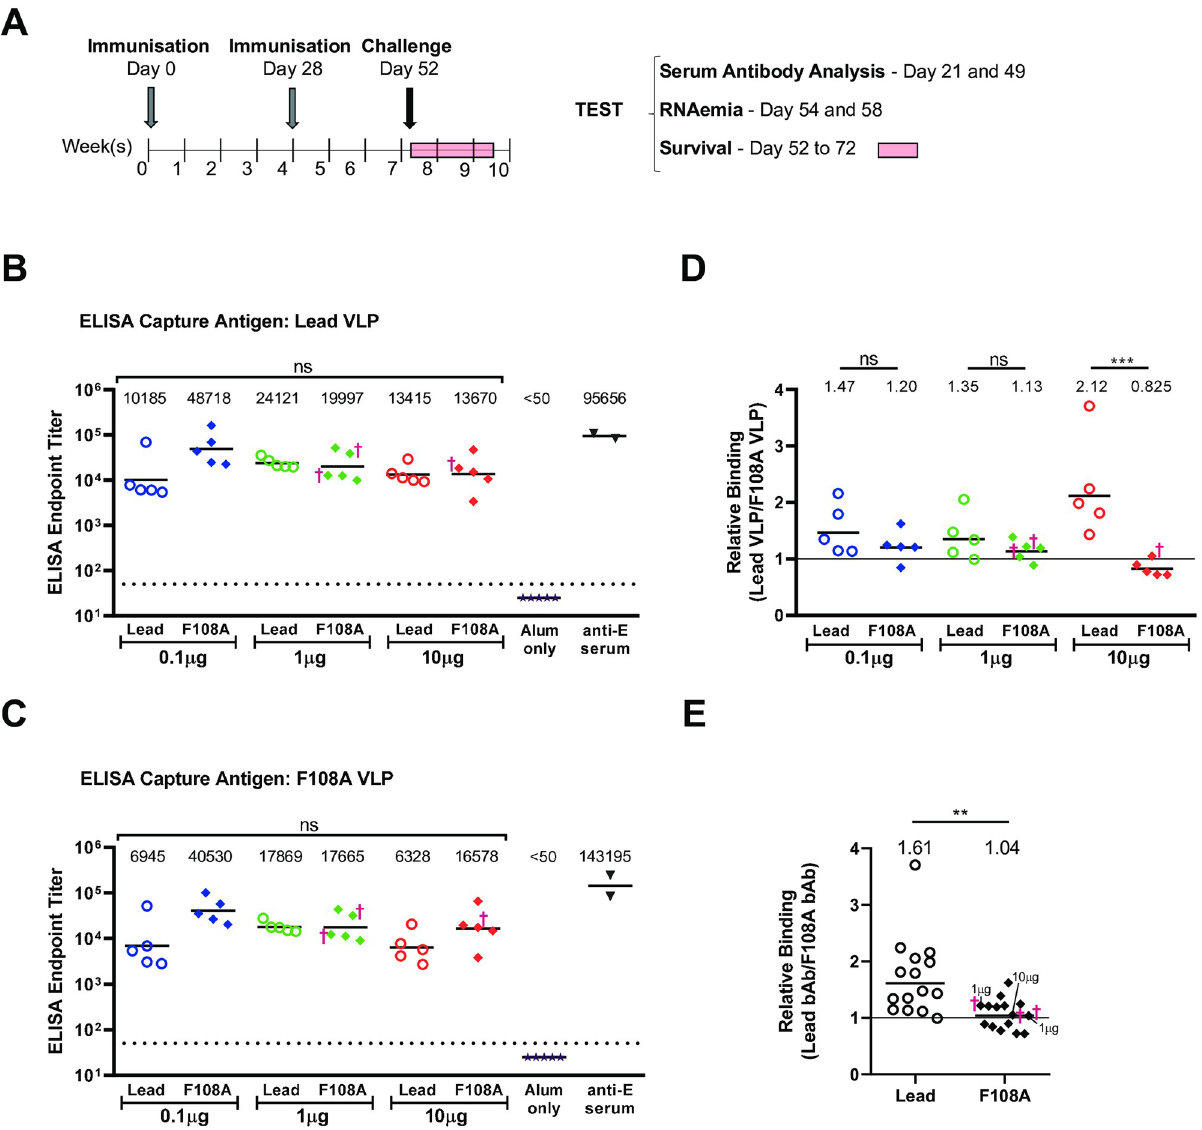
Fig 3. Vaccination and induction of lead and F108A VLP binding Abs. (A) Vaccination and bleeding schedule of AG129 mice are shown. Mice (5 per group) were immunized IM on day 0 and day 28 with doses of 0.1, 1, or 10 μ g VLP and alum adjuvant. Mice were subsequently SC challenged with ZIKV (Nica 2–16 strain) on day 52. Bleeding was performed on Days 21 and 49 of the study prior to viral challenge. Day 49 sera were tested by sandwich ELISA using captured lead (B) or F108A (C) VLPs, and endpoint titers were calculated. Each symbol represents the mean endpoint dilution of two independent measurements for an individual animal, and the geometric mean titer is depicted by a horizontal bar. The dotted line is the limit of detection (LOD) of the assay, and sera with undetectable binding were assigned a value of one-half LOD (25). Anti-E ZIKV mouse serum (Zoonogen, cat#pa10049) was used as a positive control and to demonstrate binding availability of E for the VLP types. For each capture antigen, endpoint titers of the VLP groups were compared by one-way ANOVA. The symbol † denotes a mouse that succumbed after viral challenge. (D) Relative Binding is the ratio of the lead VLP ELISA endpoint titer divided by the F108A VLP ELISA endpoint titer for each individual sample. Group geometric mean ratios are shown on top, and an equivalence line was placed at y = 1. One-way ANOVA followed by Sidak’s multiple comparison tests for each of the three doses were performed. (E) Comparison of Relative Binding Antibody (bAb) for combined lead vs combined F108A VLP groups is shown. Combined group geometric mean ratios and significance level by unpaired t test are shown on top. Dose group of F108A VLP-immunized mice that succumbed later to viral challenge is indicated. Comparison of the combined groups was by Mann-Whitney U test (ns, not significant, � P < 0.05, �� P < 0.01, ��� P < 0.001, ���� P < 0.0001).